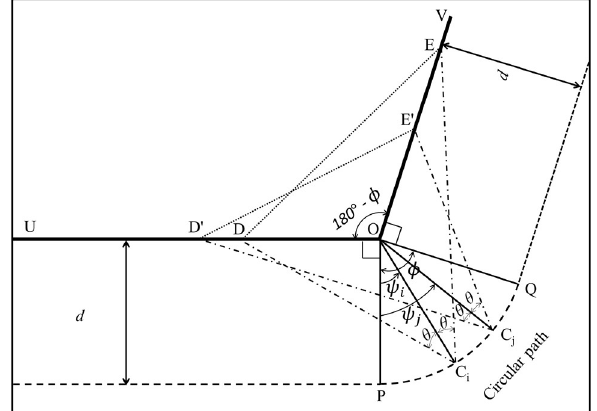
Figure 4. Geometry of a convergent image acquired on a circular